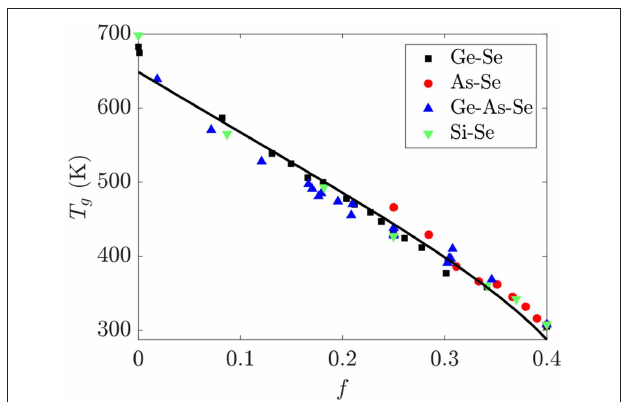
FIGURE 7 | The glass transition temperature T g for binary Ge-Se, As-Se, Si-Se and ternary Ge-As-Se glasses is nearly a linear function of the fractional degrees of freedom f . The black line is a fit using Equation (9) for the parameter values reported in the text. T g data are from Bernatz et al. (2002), Yang et al. (2010), Musgraves et al. (2011), Wang et al. (2014), Marple et al. (2017) , Zeidler et al. (2017).